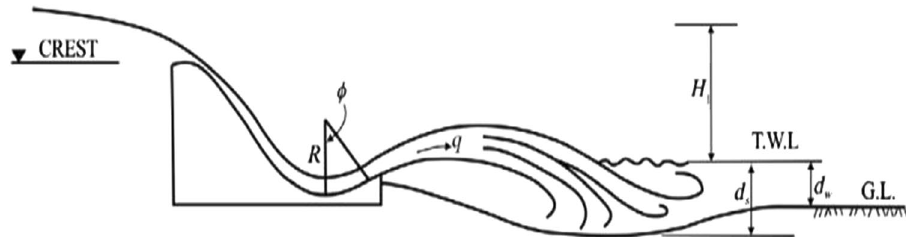
Fig. 1 Schematic profile view of ski-jump spillway and variables (Azamathulla et al.